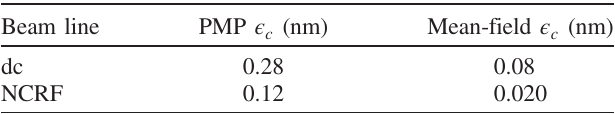
TABLE IV. Core emittance with 0 meV MTE at sample. Beam line